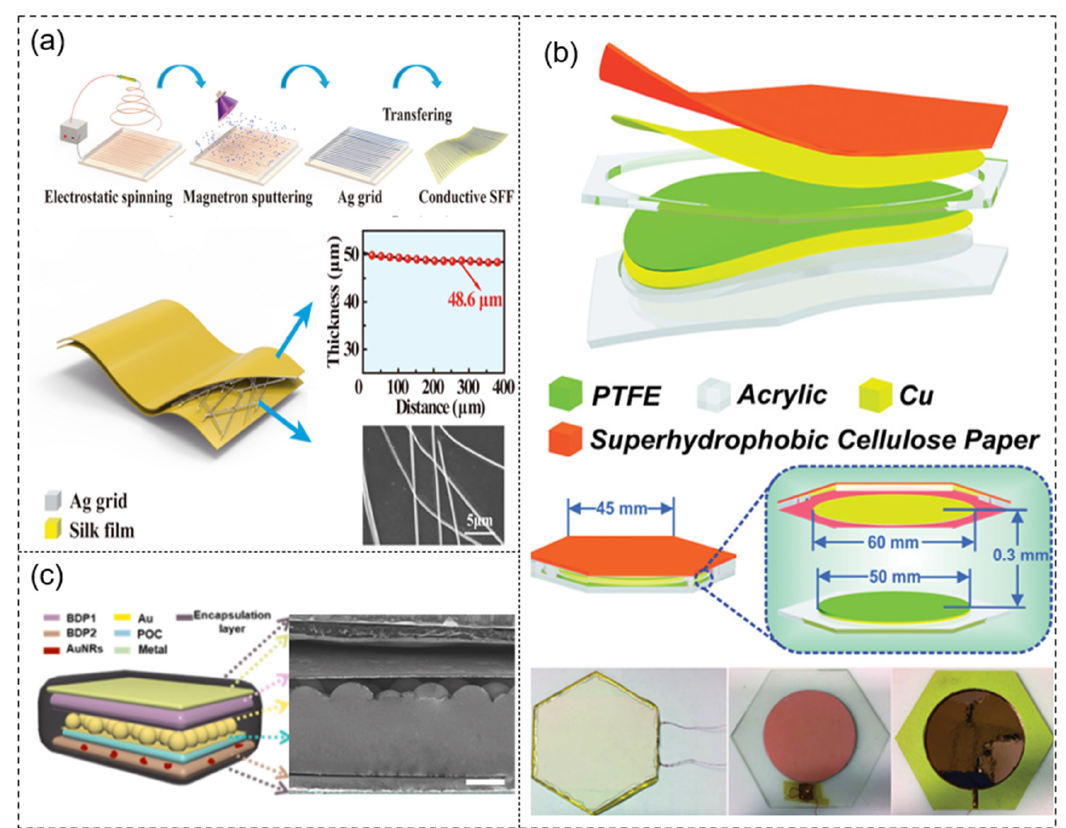
Figure 3. ( a ) Process and structure of TENGs made from animal-based materials. Reprinted with permission from Refs. [71,72,76]. Copyright 2020 Elsevier, Copyright 2021 American Chemical Society, Copyright 2018 Royal Society of Chemistry. ( b ) Basic structure scheme and digital photograph of plant-based materials. Reprinted with permission from Refs. [26,77,78]. Copyright 2018 Elsevier, Copyright 2014 John Wiley and Sons, Copyright 2020 John Wiley and Sons. ( c ) Structure design of TENGs made from artificially degradable materials. Reprinted from Ref. [66] and Reprinted with permission from Ref. [79]. Copyright 2018